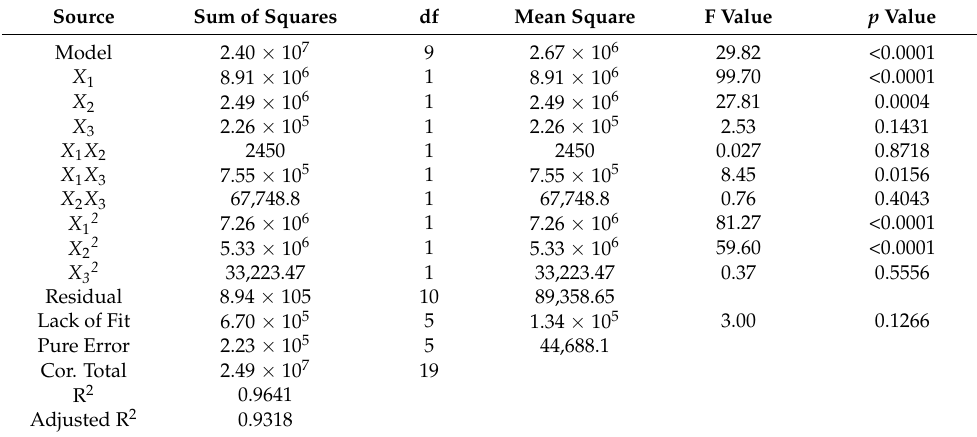
Table 4. ANOVA of the second polynomial model (UAE) for the TBPCs. Source Sum of